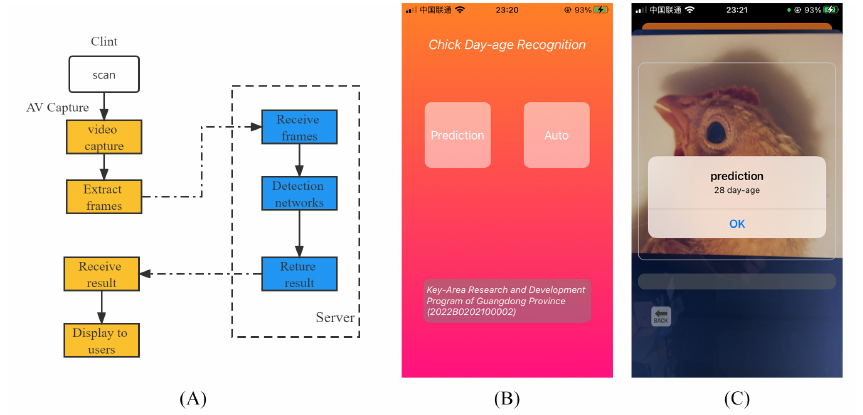
Figure 9. Illustration of chick day-age recognition application. ( A ) demonstrates the technical process of the application; ( B ) is a screenshot of the application; ( C ) is a screenshot of the application in